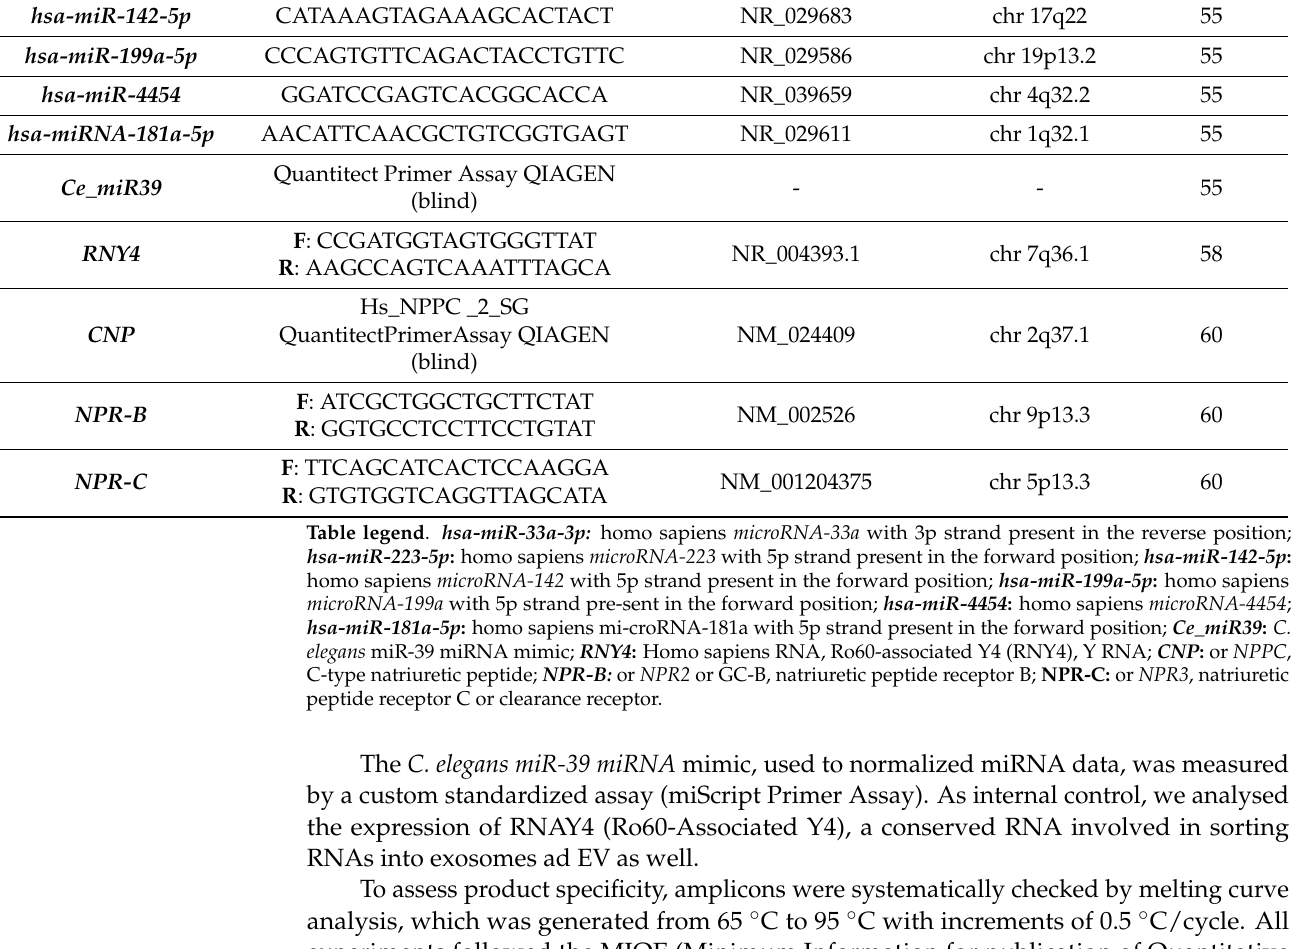
Table 3. Mature miRNA sequence and gene oligonucleotides.